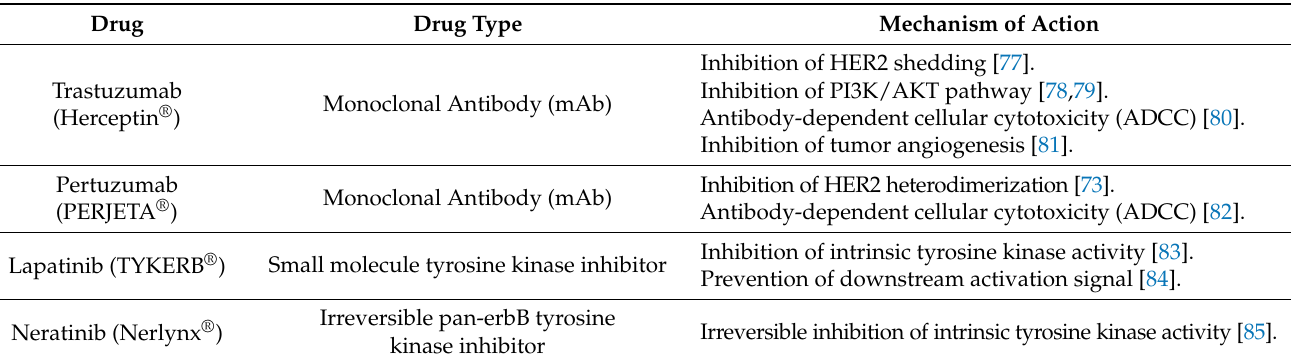
Table 1. Mechanisms of action of anti-HER2 agents.